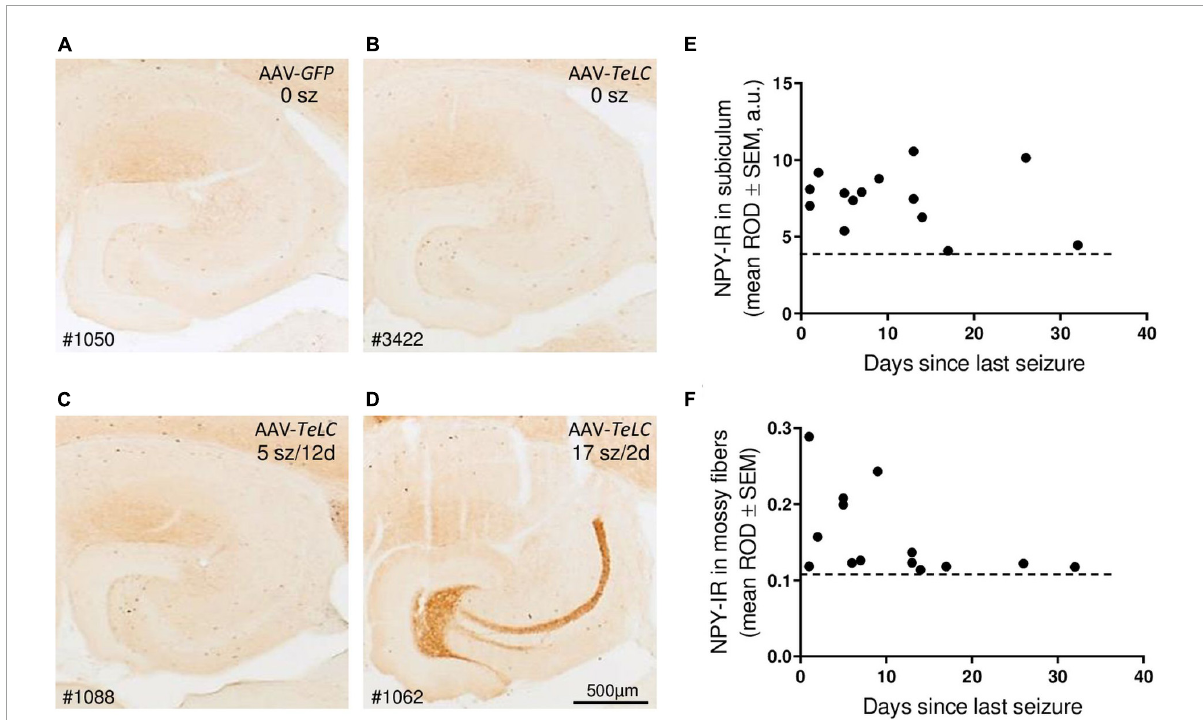
FIGURE5 Seizure-induced over-expression of NPY-IR persists in interneurons of the subiculum but in mossy fibers is restricted to mice with frequent SRS close to sacrificing. NPY-IR in the ventral hippocampus at different intervals between last SRS and sacrificing. (A) AAV- GFP -injected control mouse (no seizures); (B) mouse that experienced IS only; (C) mouse that had expressed five SRS up to 12 days before sacrificing (last seizure on day 12; note increased NPY-IR in the inner molecular layer of the subiculum and in interneurons of the dentate gyrus) and (D) mouse that had 17 seizures in total, including three severe seizures two and three days before sacrificing (note the pronounced expression of NPY-IR in mossy fibers). (E,F) NPY-IR in relation of the time of last SRS to time of sacrificing in the subiculum (E) and in mossy fibers as determined in the stratum lucidum, the terminal area of mossy fibers (F) . Horizontal dotted lines indicate the background of NPY-IR. Note that in mossy fibers increased NPY-IR was detected only in mice that had experienced their last seizure 1–5 days prior to sacrificing (F) , whereas in interneurons of the subiculum the SRS-induced increase in NPY-IR persisted for up to 25 days (E) . Optic density is given in arbitrary units